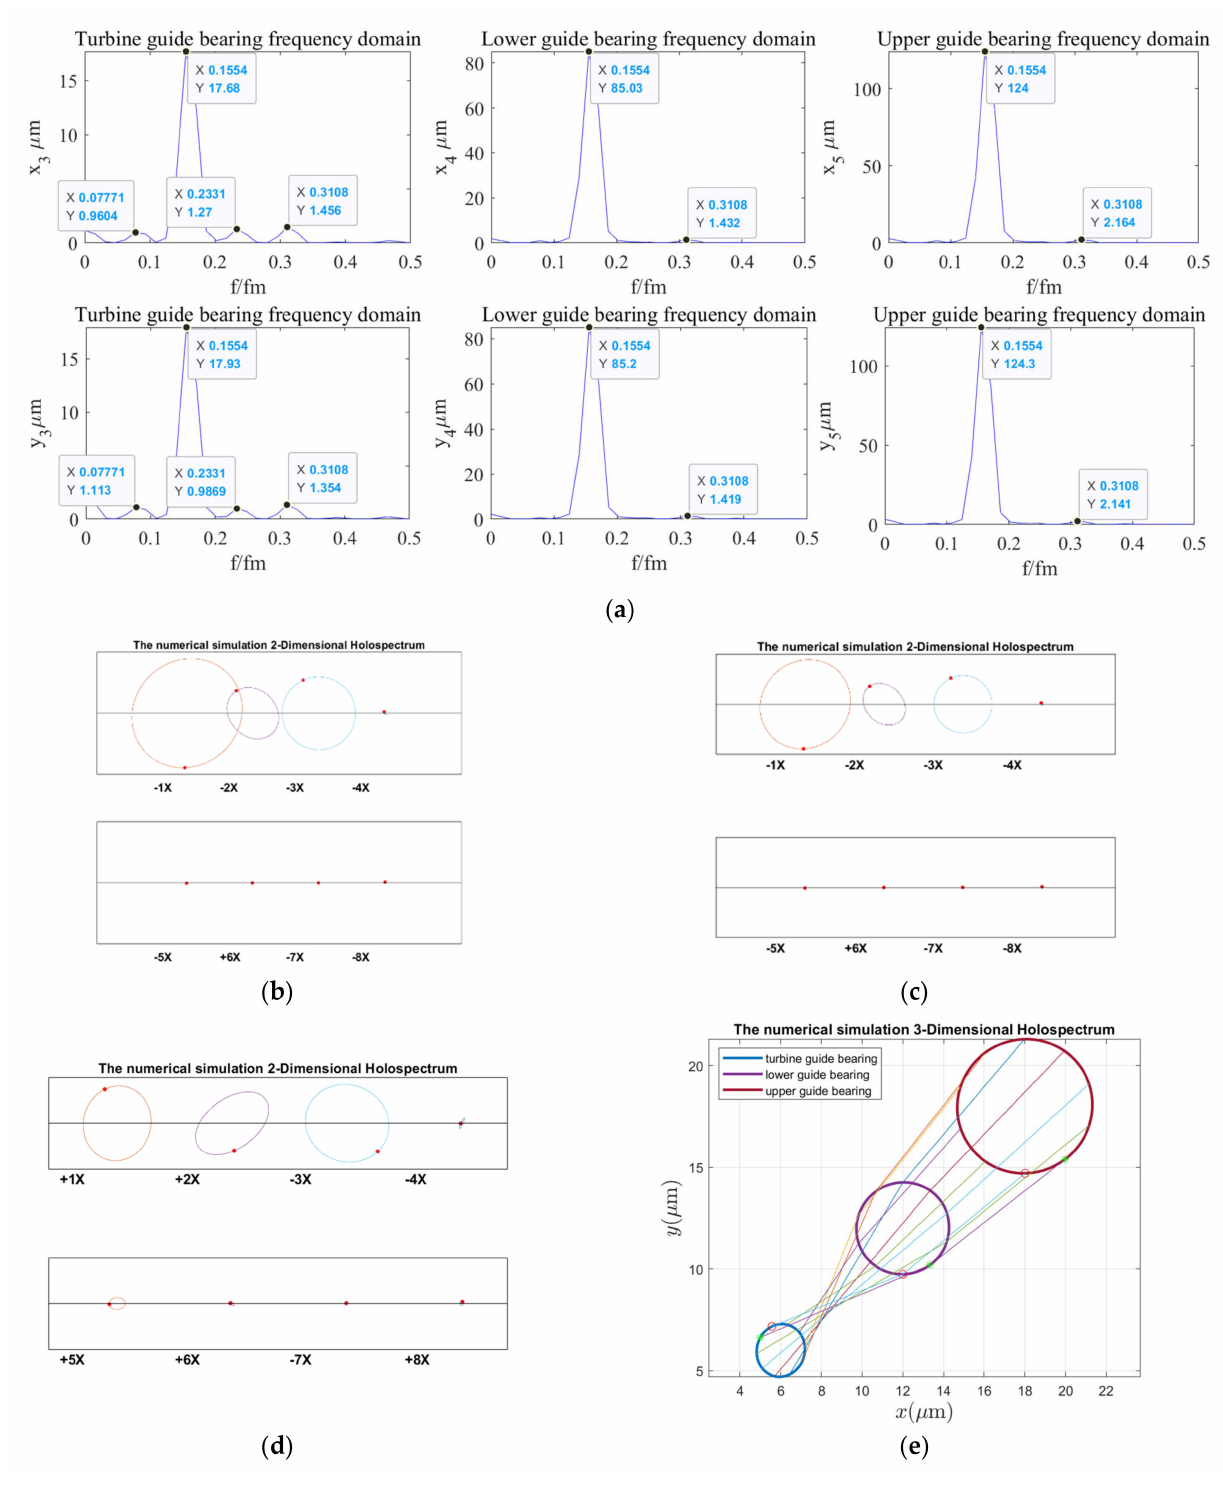
Figure 18. Holospectrum of shafting vibration of misaligned unbalance rotor, considering the oil film, RAW, rub, UMP, and turbine runner vortex eccentricity forces: ( a ) Shafting vibration spectrogram, ( b ) Upper guide bearing 2D holospectrum, ( c ) Lower guide bearing 2D holospectrum, ( d ) Hydro- turbine guide bearing 2D holospectrum, ( e ) One-fold frequency 3D